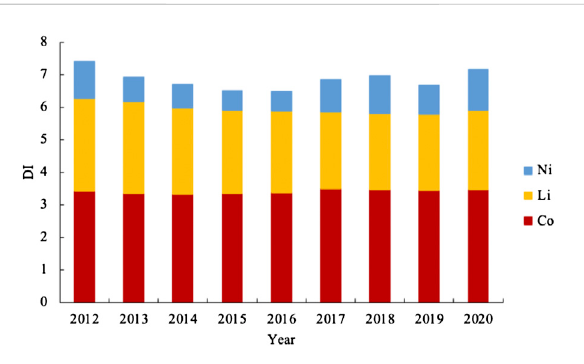
FIGURE 4 Comprehensivetrend oflithium, cobalt, and nickelresourcesupply risk index based on ICR.